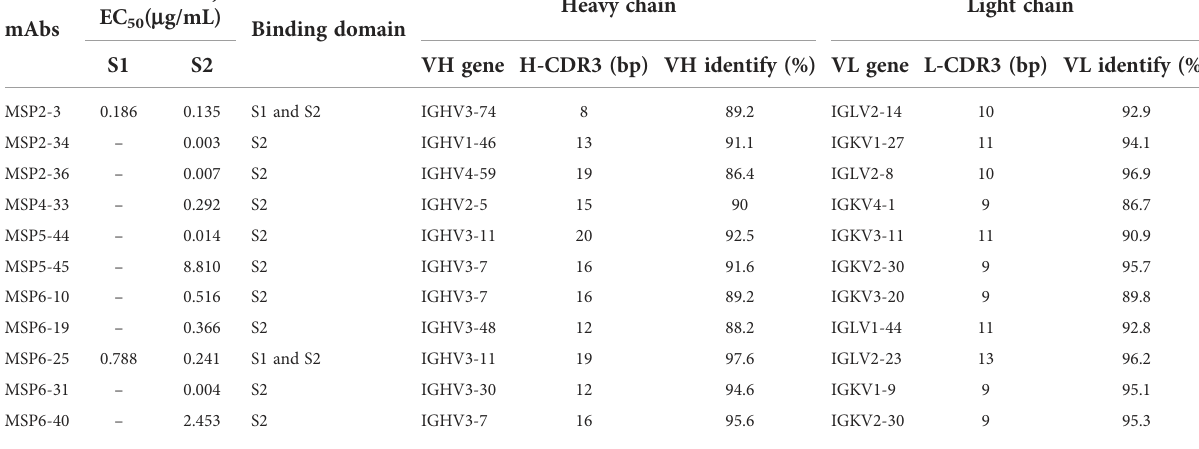
TABLE 1 Genetic characteristics of mAbs with reactivity against MERS-COV S1 and/or S2. MERS-CoV, EC 50 ( m mAbs